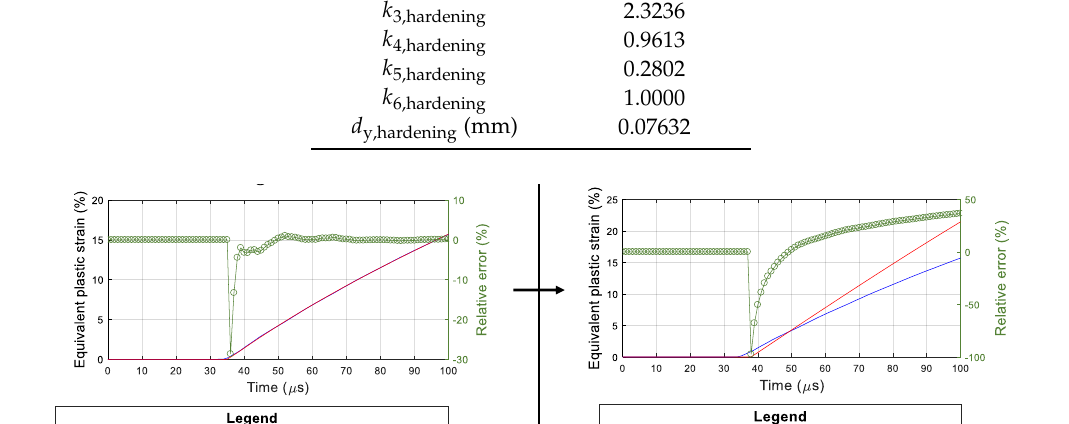
Table 8. Values of k i ,hardening and d y,hardening parameters used for data processing of SCS (identification considering the strain-hardening of Table 7.